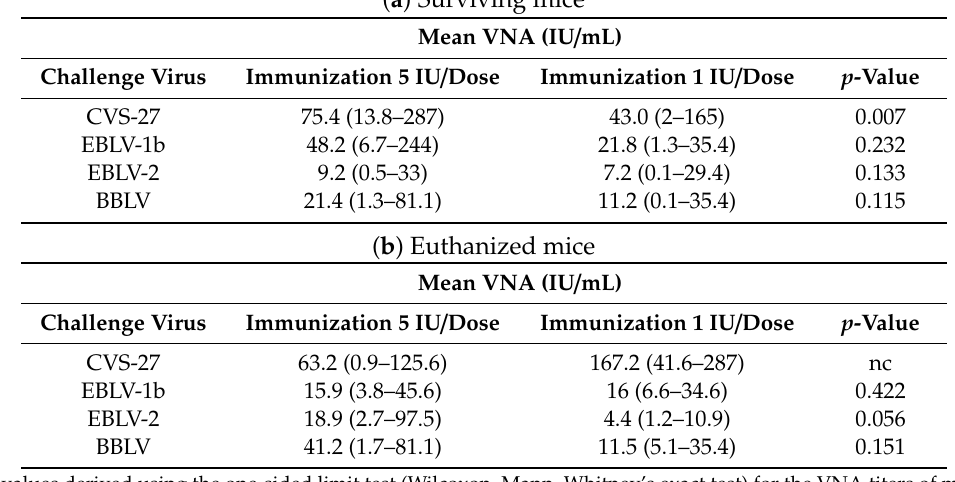
Table 2. Comparison of mean virus neutralizing antibody (VNA) titers (IU / mL) in mice immunized with two di ff erent dosages of RABISIN inactivated vaccine and challenged with either CVS, EBLV-1b, EBLV-2, or BBVL: ( a ) surviving mice and ( b ) mice that were euthanized after onset of rabies clinical